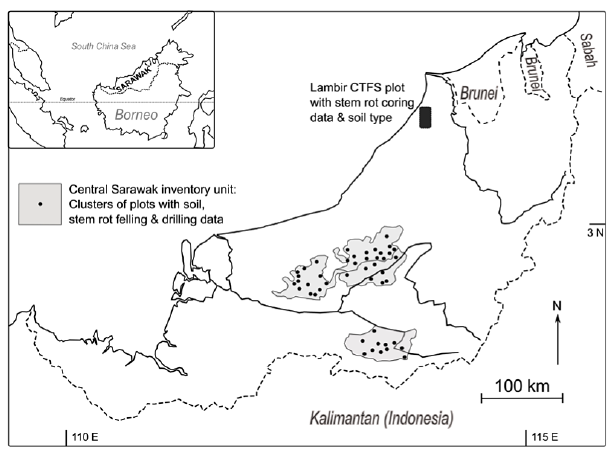
Figure 1. Location of study sites in Sarawak, Malaysian Borneo. Shaded areas are the Central Sarawak inventory units for stem rot felling and drilling data, with clusters of plots indicated by black dots. The black rectangle (not to scale) indicates the location of the Lambir Hills National Park study site for the stem rot coring